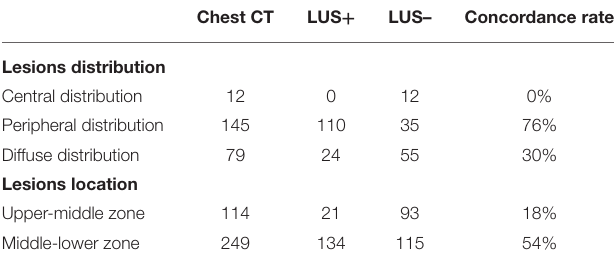
TABLE 2 | Concordance rate between LUS and CT scan in assessing lung lesions according to their distribution and location. Chest CT LUS +